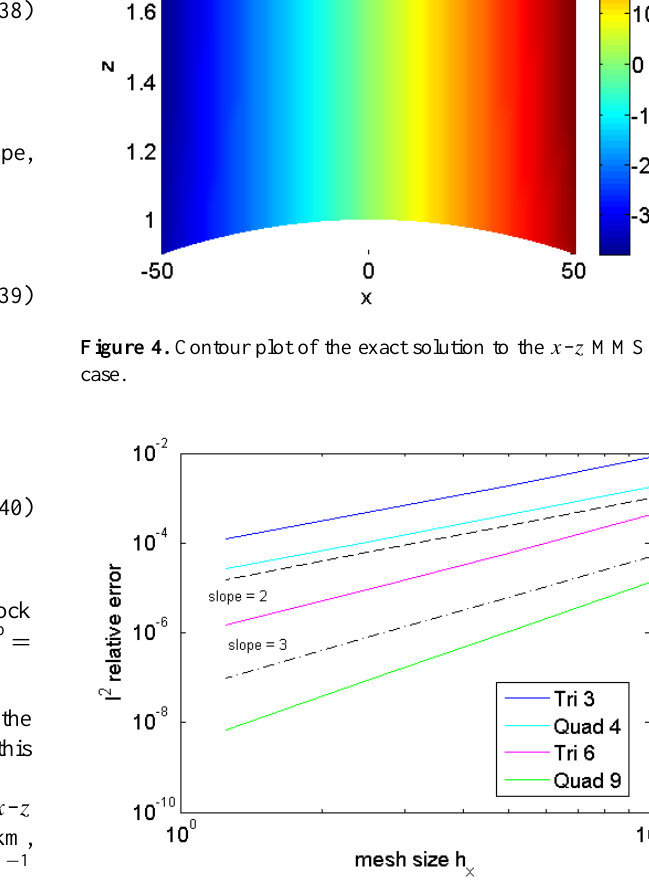
Figure 5. Convergence rates for the x – z MMS test case in the dis- crete l 2 norm Eq.